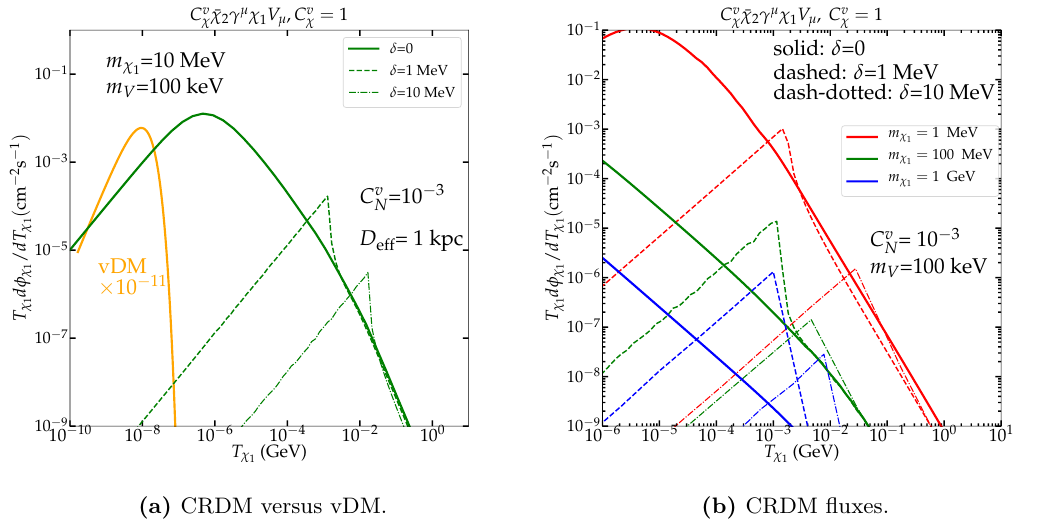
Figure 6. (a) Comparison of vDM and CRDM fluxes. Both vDM and CRDM fluxes are obtained by using ¯ χ interaction with m = 10 MeV , m = 100 keV , and C a = 10 − 3 . The value of µ χ 2 γ 1 V µ χ 1 V N D eff for CRDM is fixed to 1 kpc as a default value. (b) Spectra of CRDM with the VV interaction. Three benchmarks of DM mass 1 MeV (red lines), 100 MeV (green lines), and 1 GeV (red lines) are presented. We also plot three different mass splittings, δ = 0 (solid lines), δ = 1 MeV (dashed lines), and δ = 10 MeV (dash-dotted